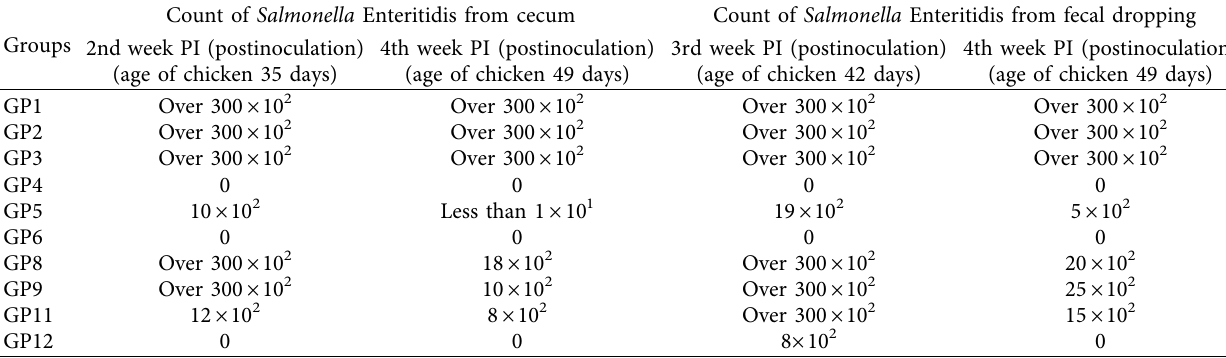
Table 4: Results of effect of total Salmonella Enteritidis count in in vivo challenge.